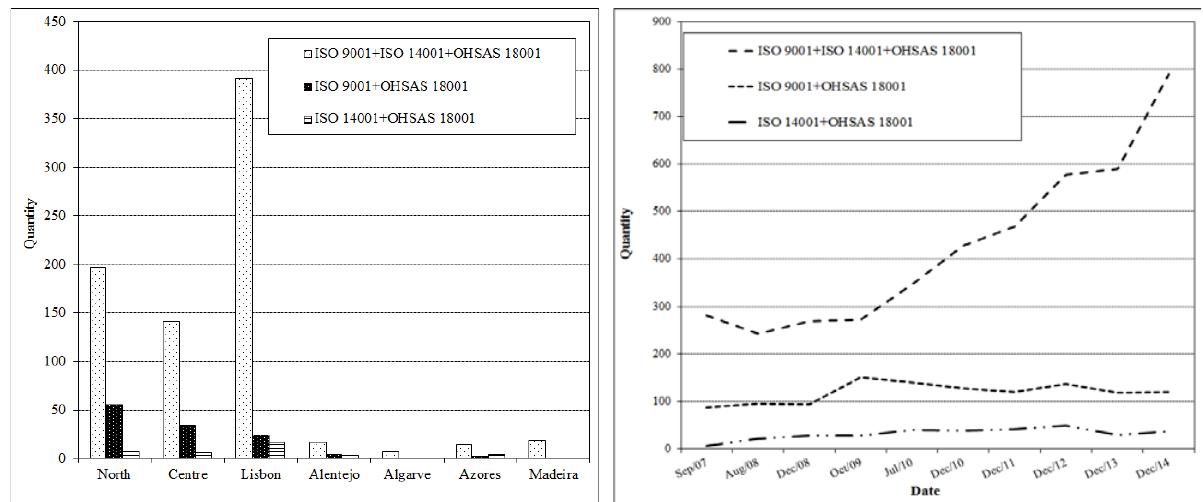
Figure 7. Integrated OHSMSs- Breakdown by typology and NUT II region (Portugal- 31/Dec/2014).